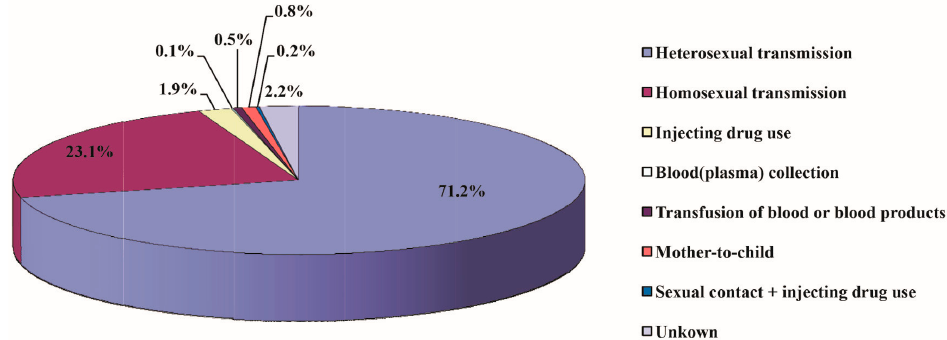
Figure 7. Routes of transmission of all reported HIV/AIDS cases in Fujian Province from 1987 to 2015.